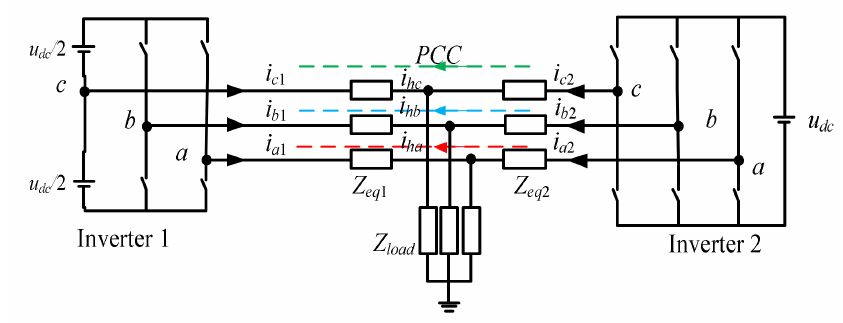
Figure 3. The circulating